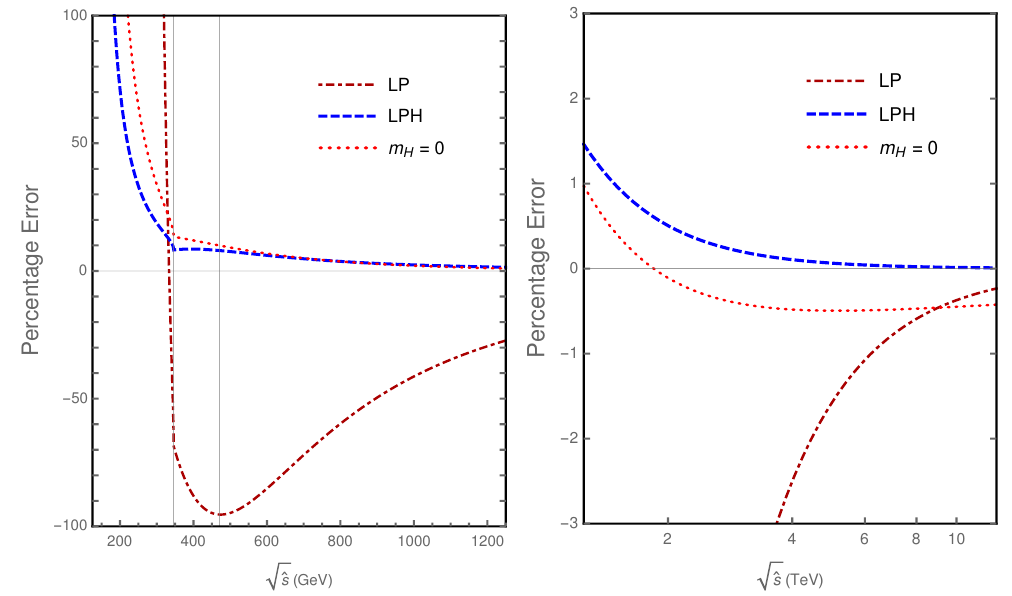
Figure 8 . Percentage errors in form factors for q (cid:22) q ! H + g as functions of the center-of-mass p energy ^ s : the m H = 0 form factor (dotted curve), the LP form factor (dot-dashed curve), and the p LP H form factor (dashed curve). The ranges of ^ s are from m H to 10 m H on a linear scale (left panel) and from 10 m H to 100 m H on a log scale (right panel). The two vertical lines mark the t (cid:22) t threshold 2 m t and the t (cid:22) tH threshold 2 m t + m H